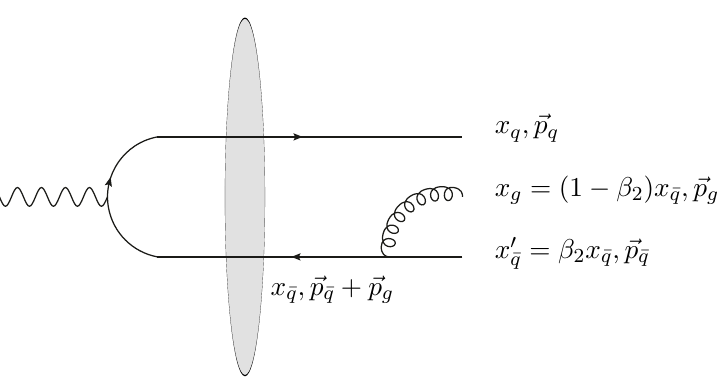
Figure 10 . Kinematics for the ¯ q − g splitting contribution. We indicate the longitudinal fraction of momentum carried by the partons as well as their transverse